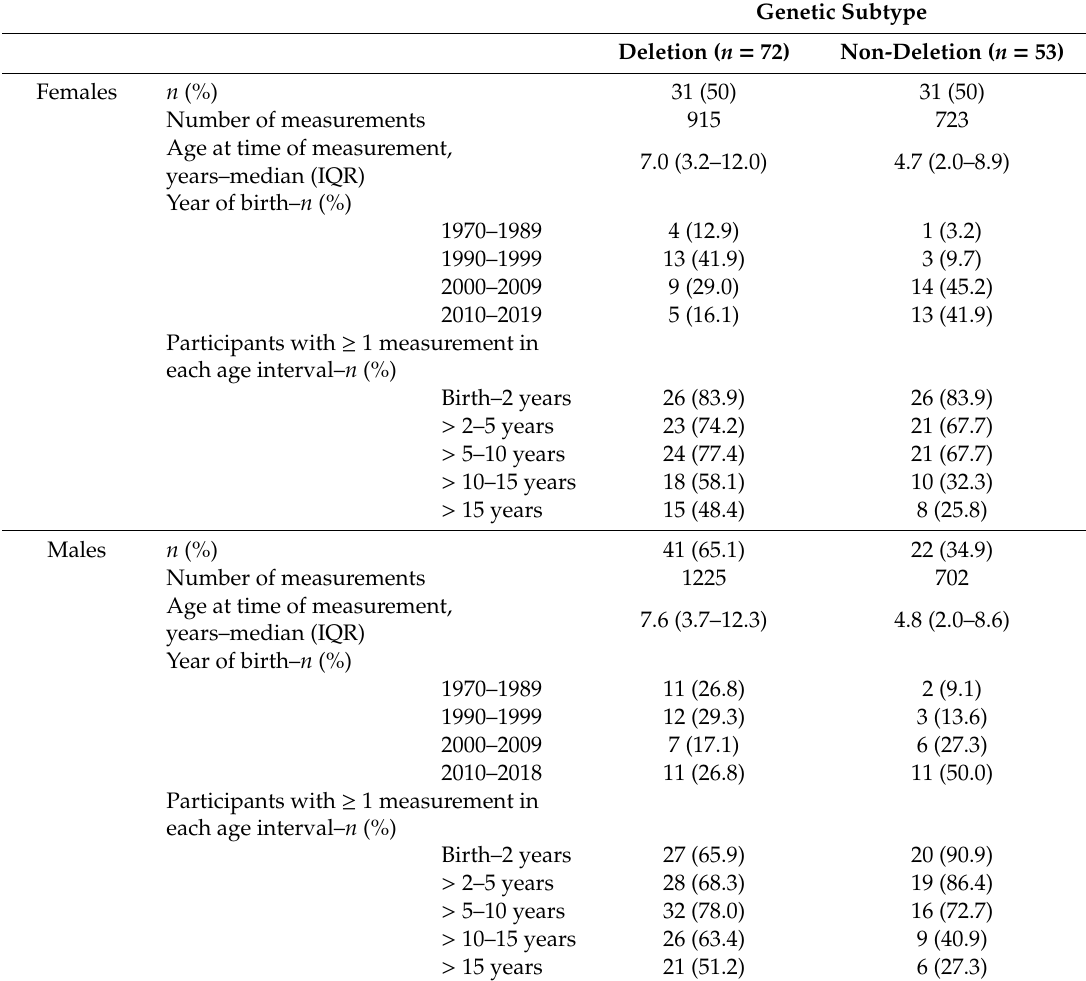
Table 1. Characteristics of the study